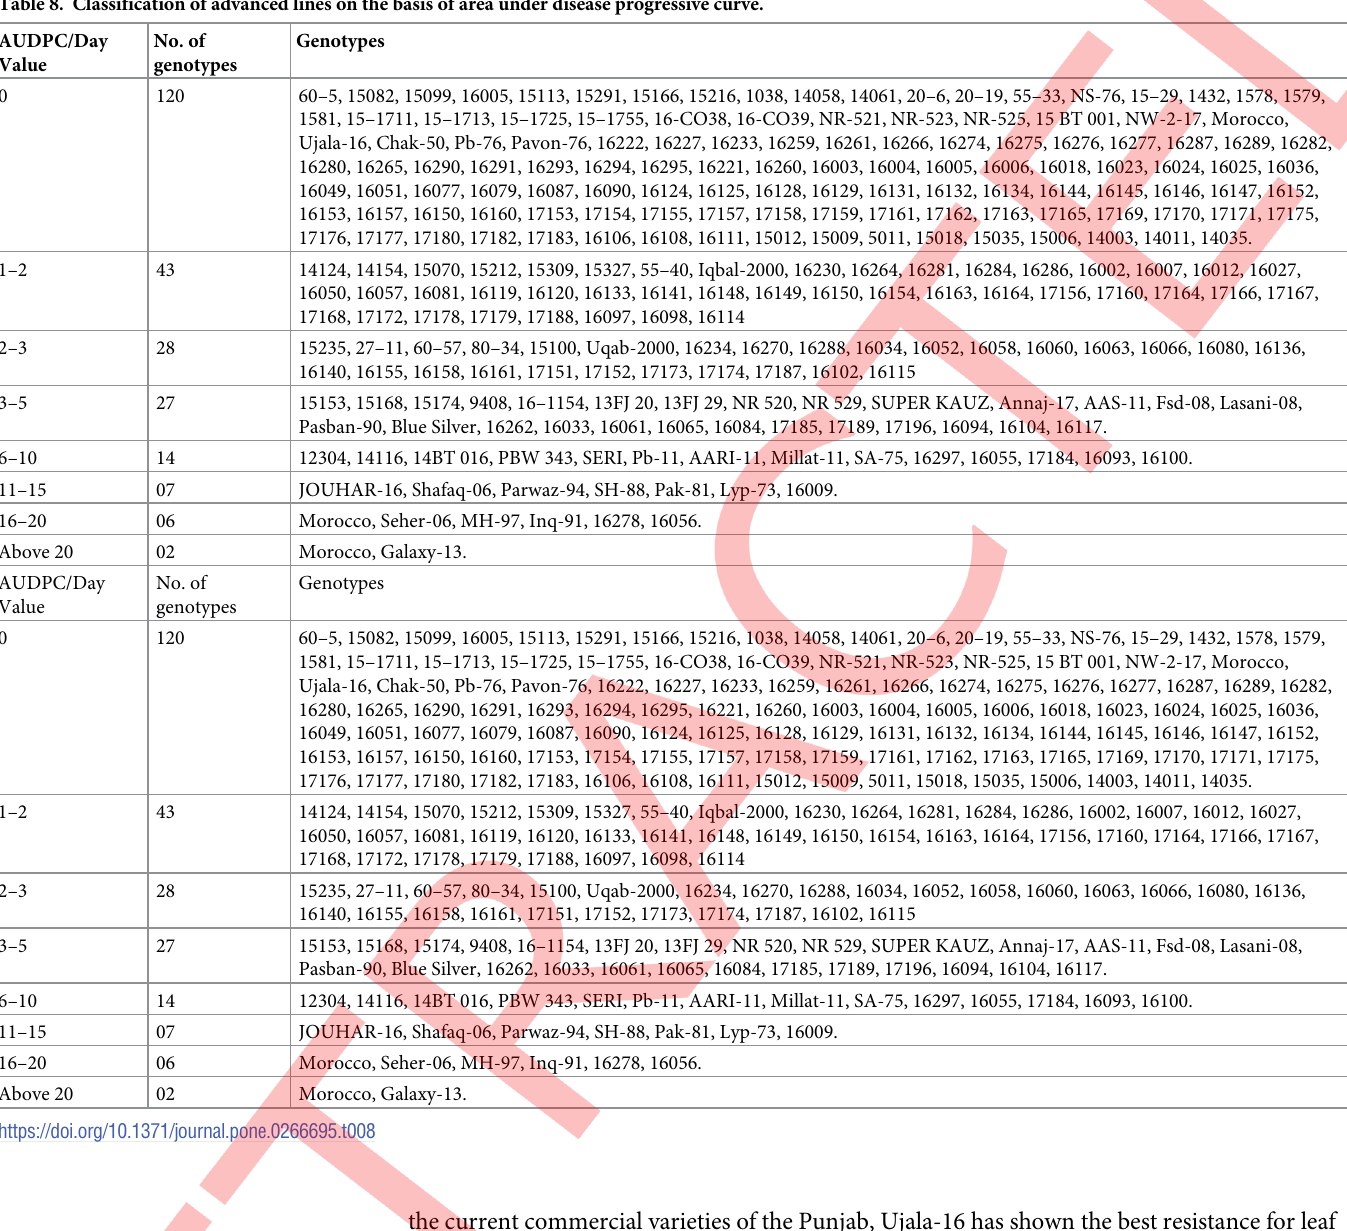
Table 8. Classification of advanced lines on the basis of area under disease progressive